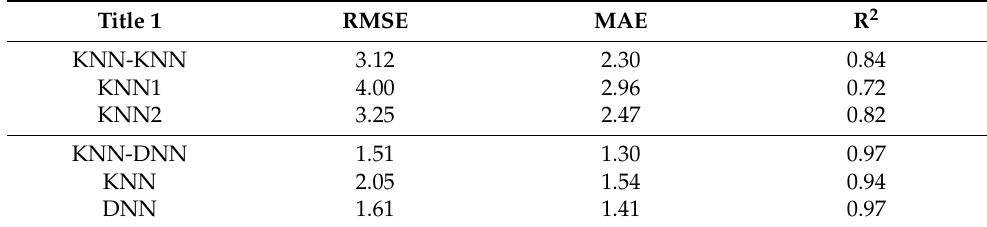
Table 1. Comparison of each learner in co-training semi-supervised learning